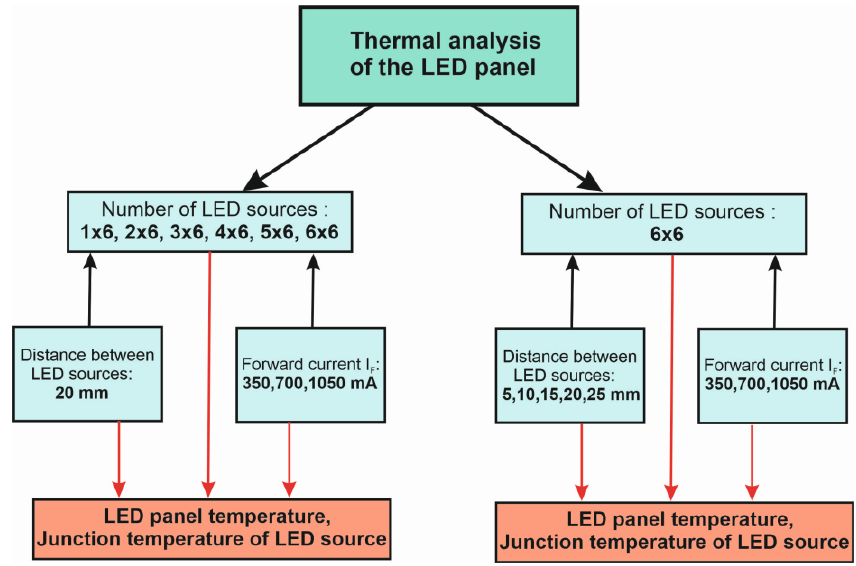
Figure 6. Graphical representation of the variable parameters of the thermal analysis of the LED panel.